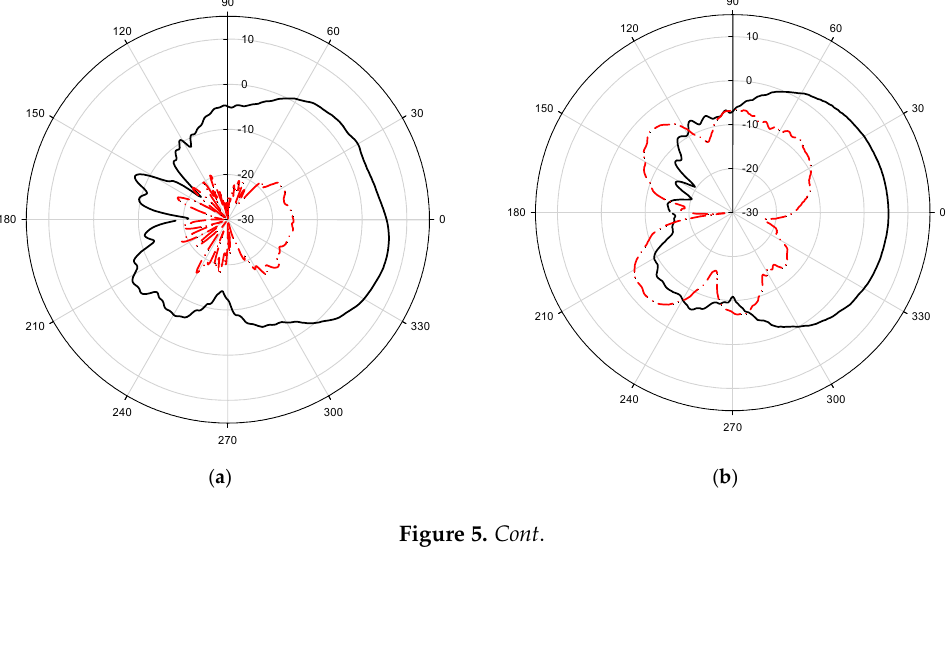
the frequency-independent phase shifter is replaced by a simple feed line. As shown in the radiation plot, the beam is split into two halves, losing the tendency to be directive, and has a reduced gain. be directive, and has a reduced gain.